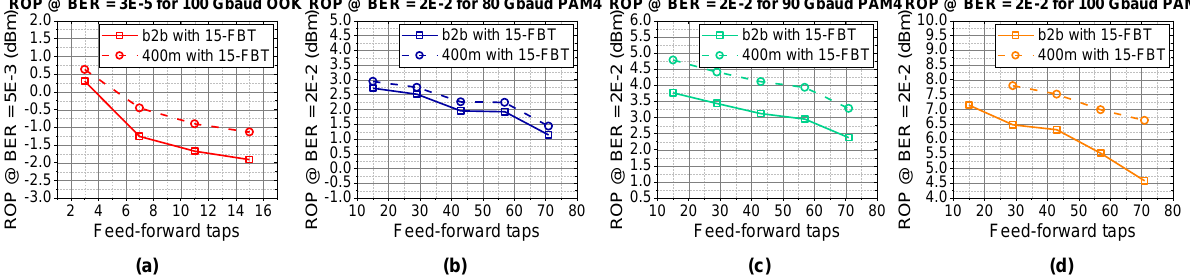
Figure 2. Received optical power versus different configurations of decision feedback equalizers for ( a ) 100 Gbaud OOK, ( b ) 80 Gbaud PAM4, ( c ) 90 Gbaud PAM4, and ( d ) 100 Gbaud PAM4 signals.